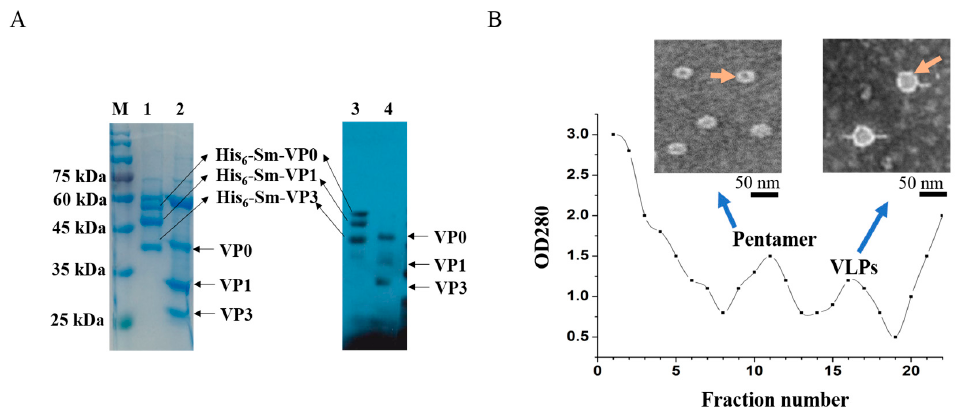
Figure 2. Expression and assembly of SVA capsid protein. ( A ) SDS-PAGE (Lanes 1, 2) and western blot (Lanes 3, 4). Lanes 1, 3: SVA purified capsid-protein complexes His 6 -sm-VP0, His 6 -sm-VP1 and His 6 -sm-VP3. Lanes 2, 4: Target proteins VP0, VP1, VP3 purified after protease digestion; ( B ) SVA